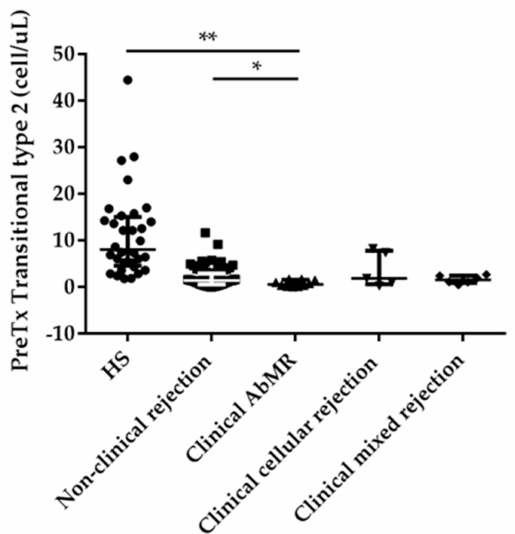
Figure 3. Significant reduction in the absolute number of pretransplant transitional type 2 cells in antibody-mediated rejection (AbMR; n = 11) when compared with the non-rejection group ( n = 87) and healthy subjects (HS; n = 40). * indicates p < 0.05, and ** p <